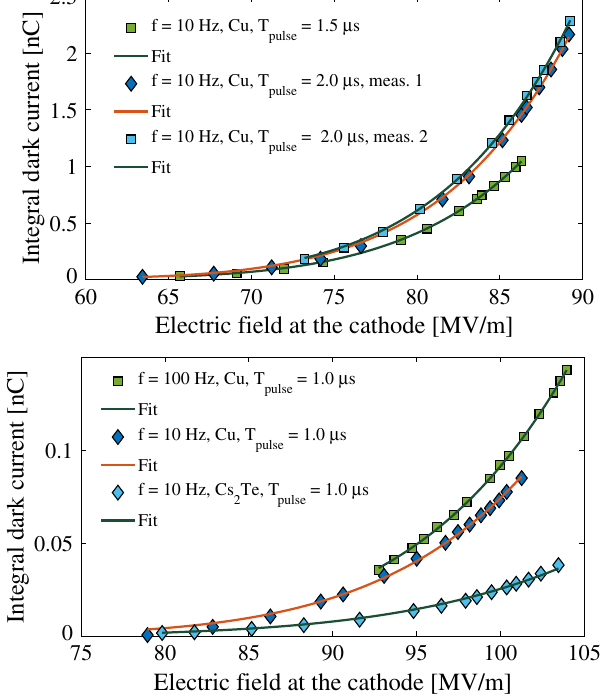
FIG. 10. Dark current versus the maximum electric field at the cathode measured for the CTF2 (top) and SwissFEL (bottom) guns. The repetition rate during the measurement, f , and the rf full pulse width, T , are also indicated. pulse